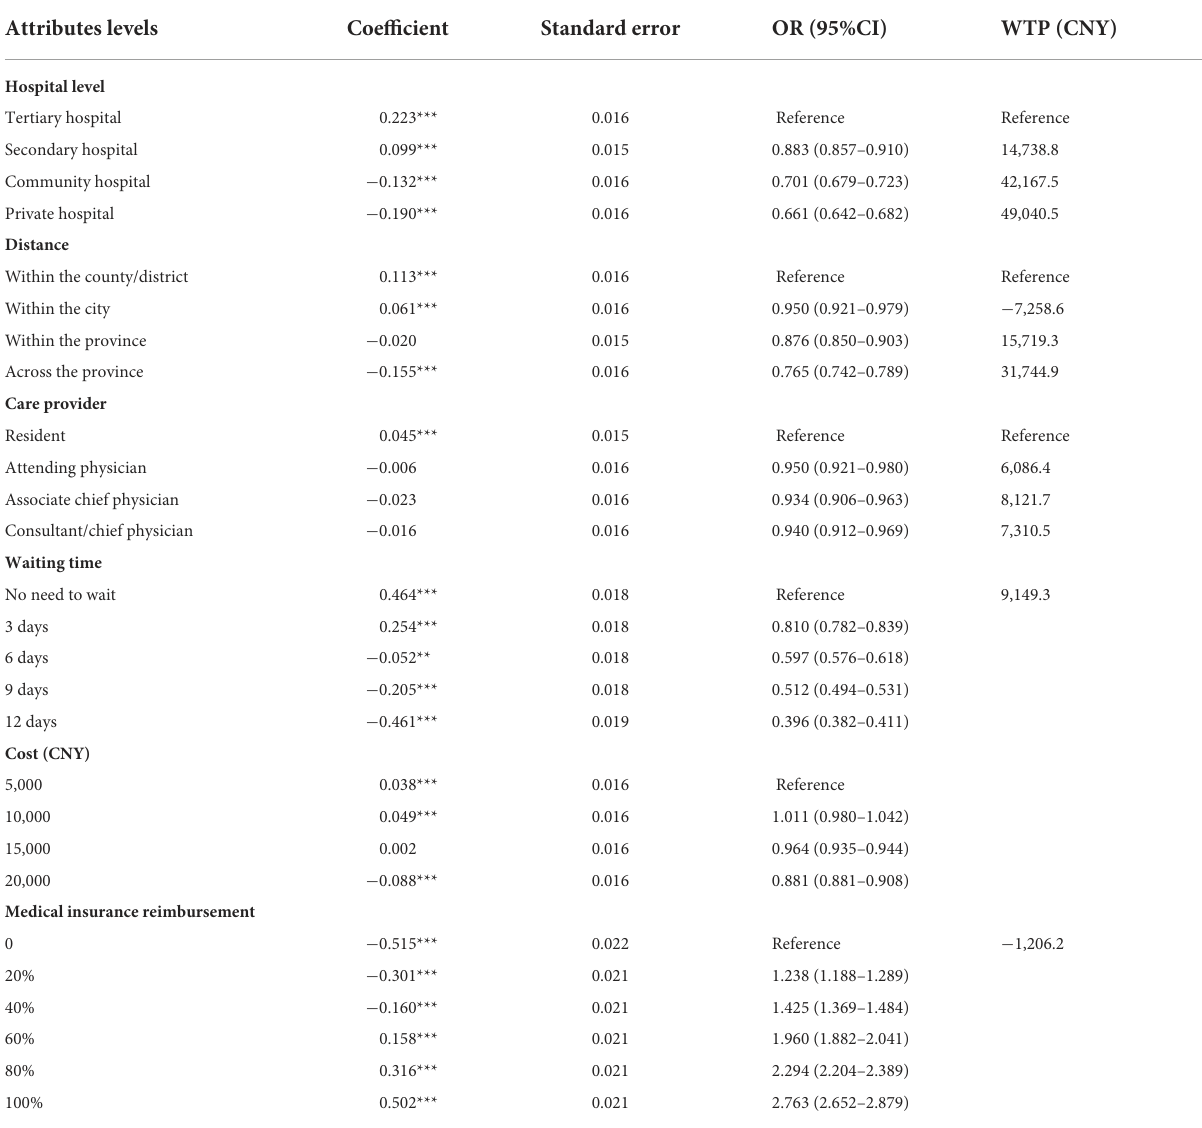
TABLE 5 Attributes and levels of acute infectious diseases